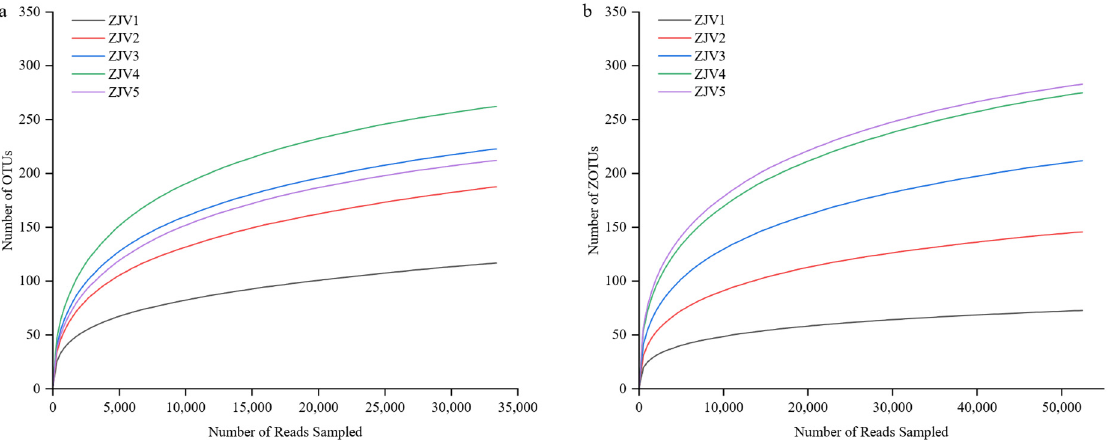
Figure 3. Rarefaction curves for bacteria ( a ) and fungi ( b ).